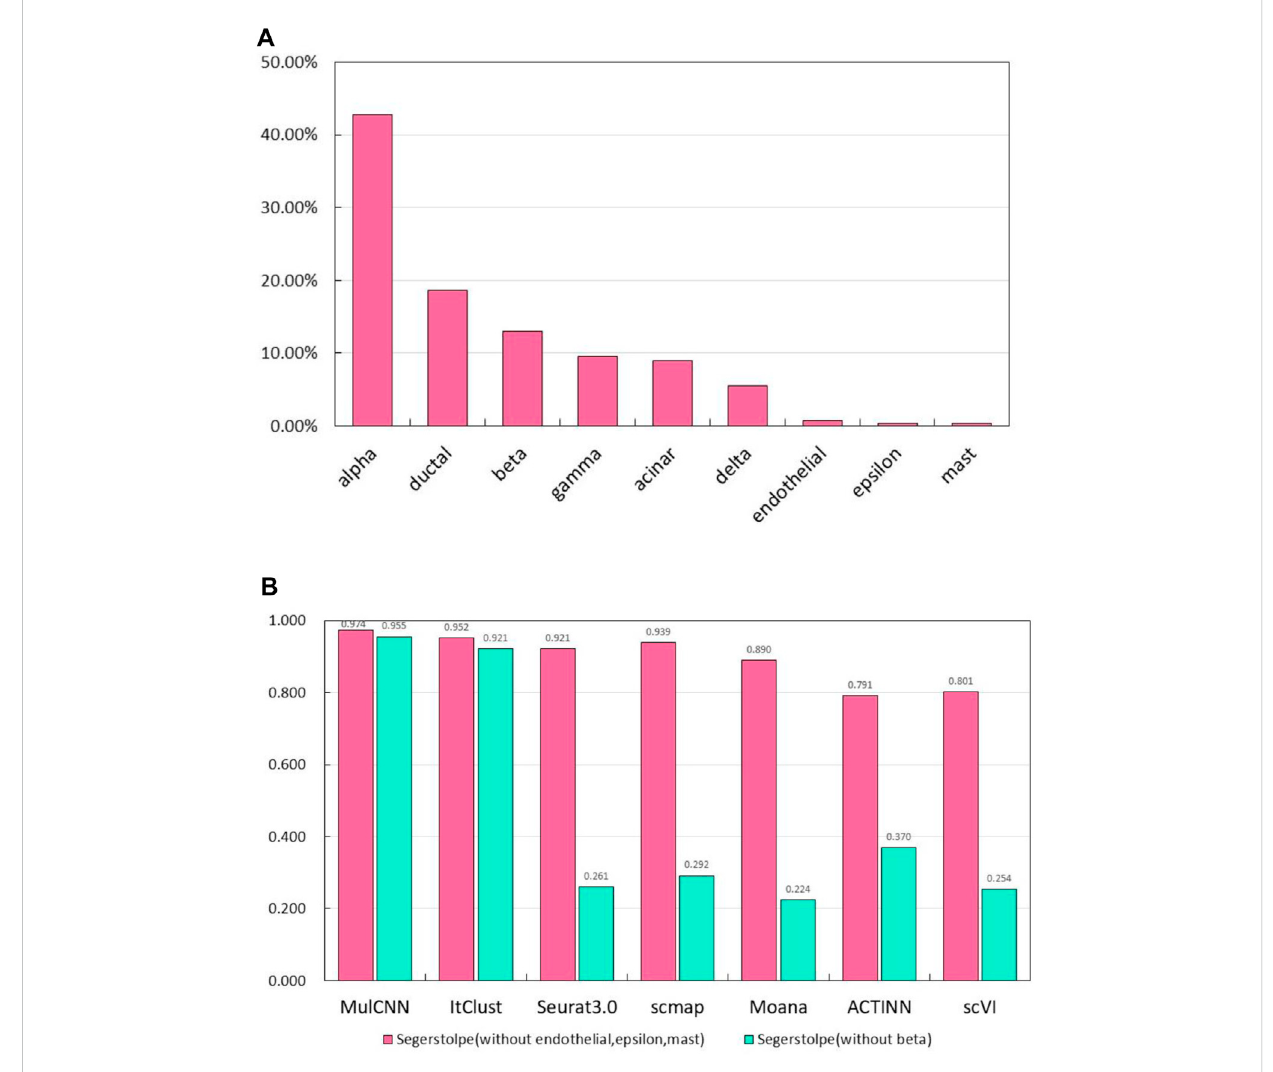
FIGURE 8 Results ofexperiments toidentifypseudocell types. (A) Per-centageofeachcelltypeintheSegerstolpedataset; (B) AccuracyofMulCNNandother super-vised algorithms in the case of missing categories in the segerstolp